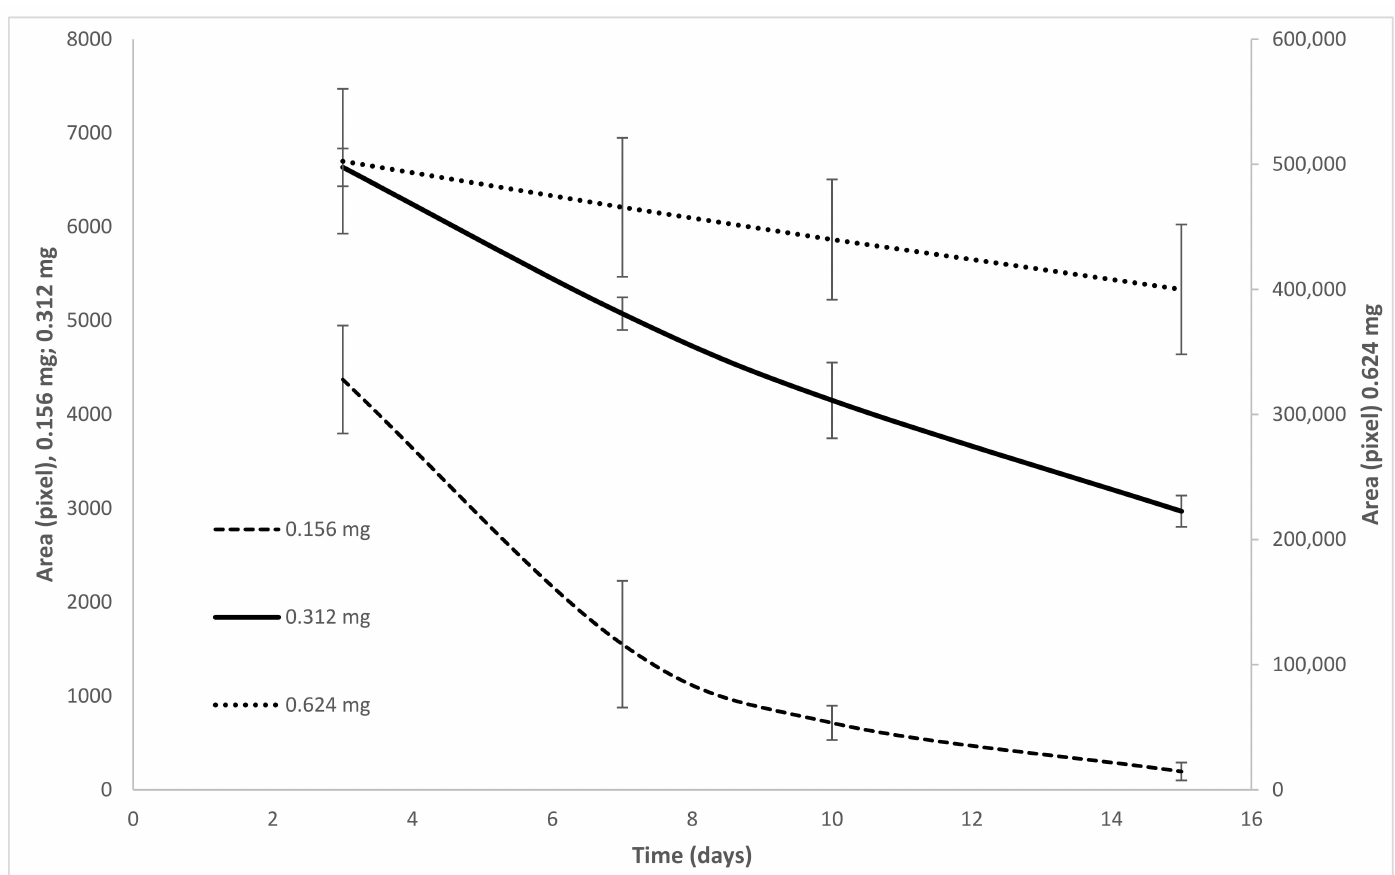
Figure 2. Dose response curve of the daily evolution of the eye injury caused by TPA. Tissue damage was evaluated by the lesion surface revealed by fluorescein. The damaged area was quantified in pixels. The evolution trend of the lesion followed a behavior that was adjusted to an exponential decay curve: y = 5.32 × 10 5 e − 0.019x (TPA doses 0.624 mg); y = 8111e − 0.067x (TPA doses 0.312 mg); y = 9509e − 0.259x (TPA doses 0.156 mg) (n =